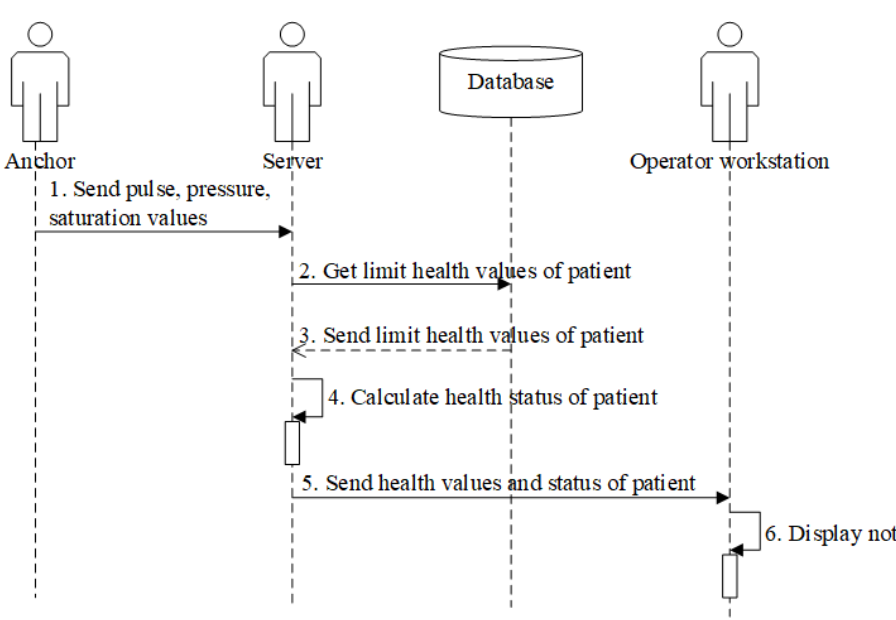
Figure 3. The process of monitoring the health indicators of a patient.